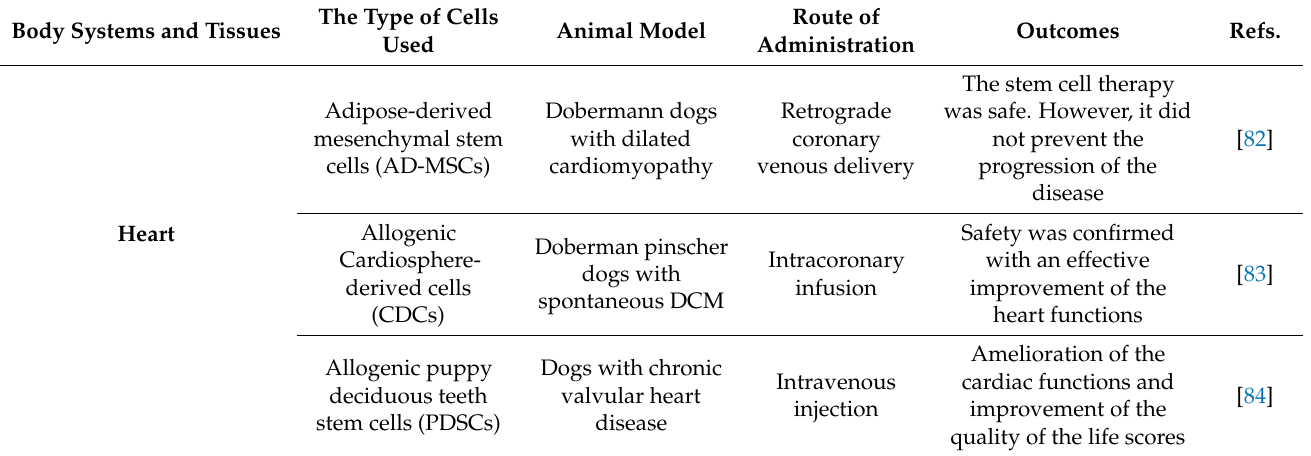
Table 1. Employment of diverse kinds of stem cells in the regeneration of various body tissues in different